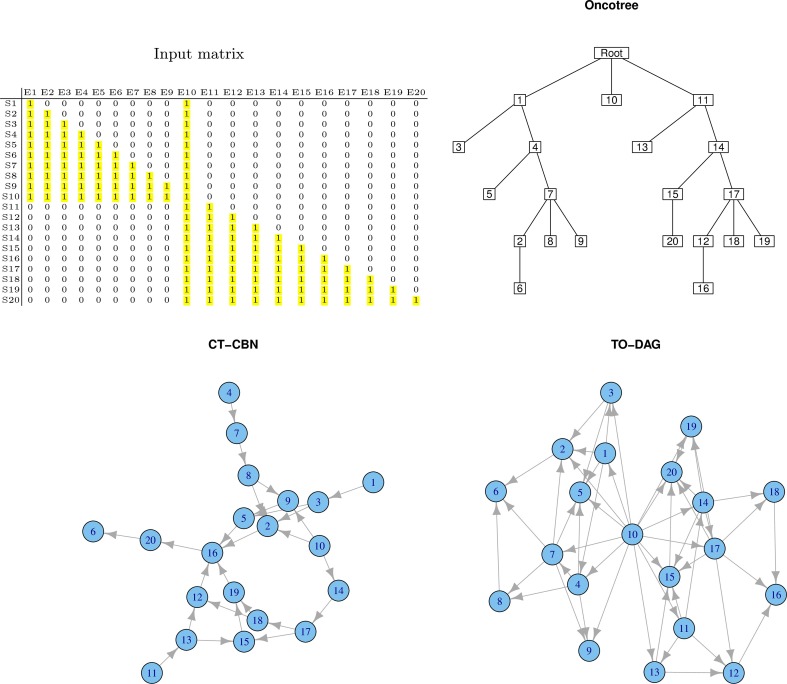
Output graphs obtained from intersecting sample sets, i.e., set of samples that share at least one mutation event.